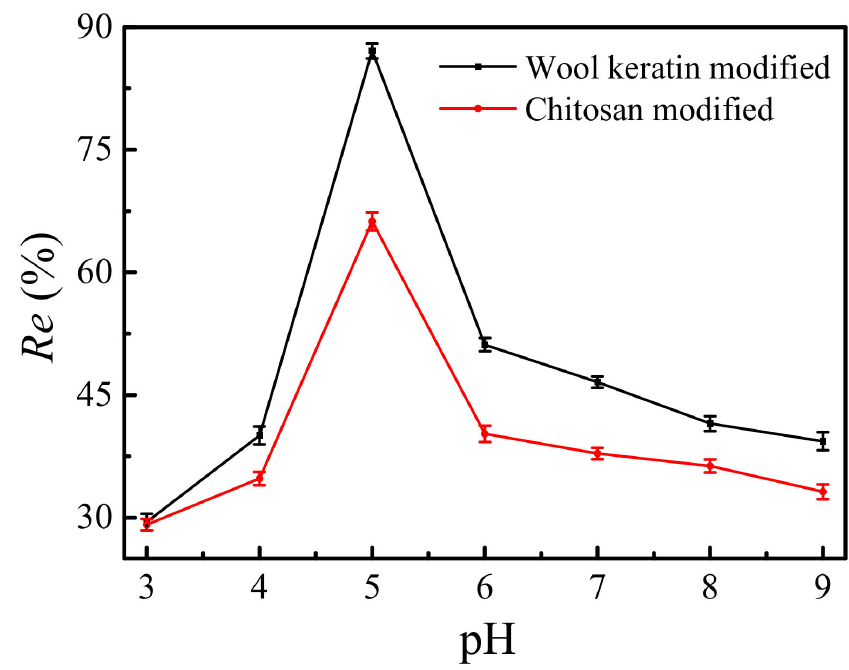
Figure 11. The effects of the pH values of solutions on the removal efficiencies of Cu 2+ ions by the as-fabricated Fe 3 O 4